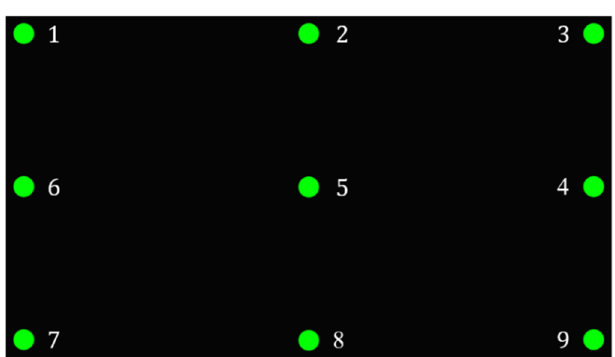
Figure 49. Gaze point sequence.